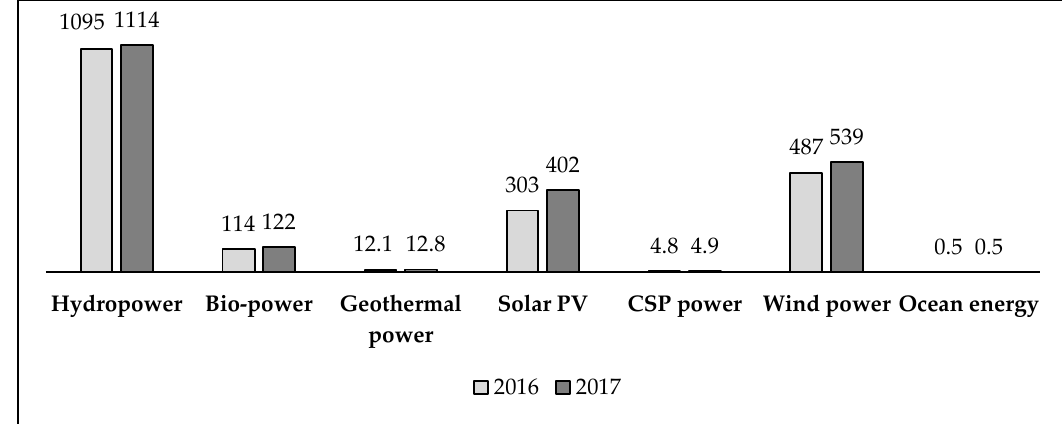
Figure 1. Cumulative global renewable power capacity. Data expressed in GW (REN21 2018).